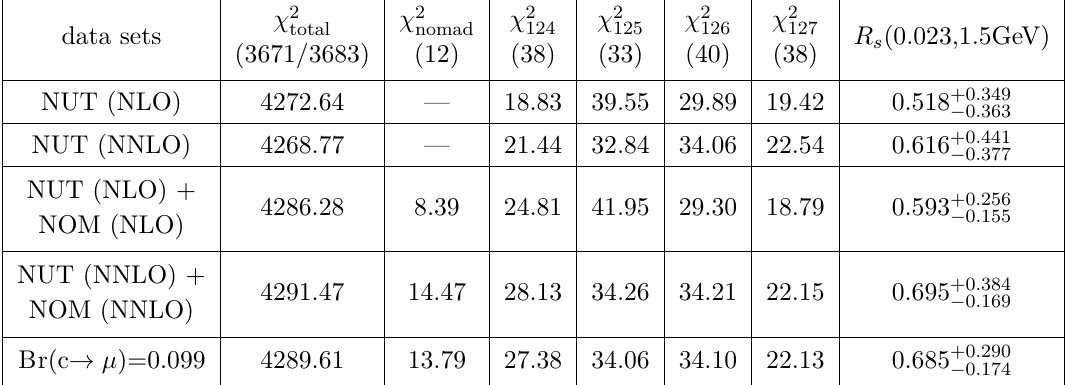
Table 7 . Total χ 2 and individual χ 2 of dimuon data for global fits with various conditions. Numbers in the first row indicate the total number of data points. The last column includes predictions on R s ( x = 0 . 023 , Q = 1 . 5GeV) with uncertainties at 90%